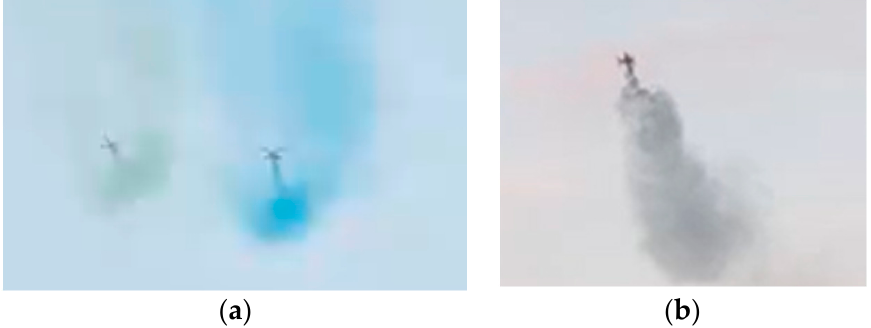
Figure 3. Spraying effects at different smoke tube positions, should be listed as: ( a ) below the UAV; ( b ) above the UAV.